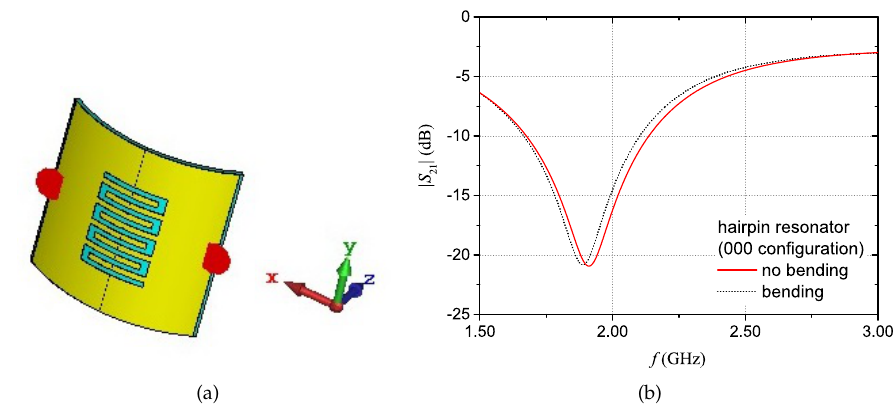
Figure 14. Hairpin resonator structure: curved configuration ( a ) and simulation results of the magnitude of the S 21 with “bending” and with “no bending” of the structure ( b ).